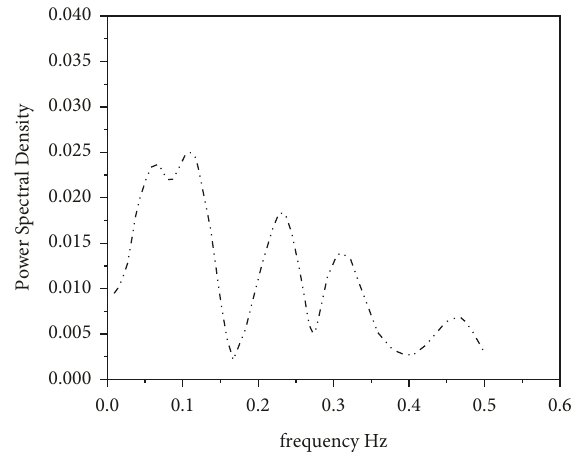
Figure 4: HRV power density spectrum of Lomb–Scargle method.